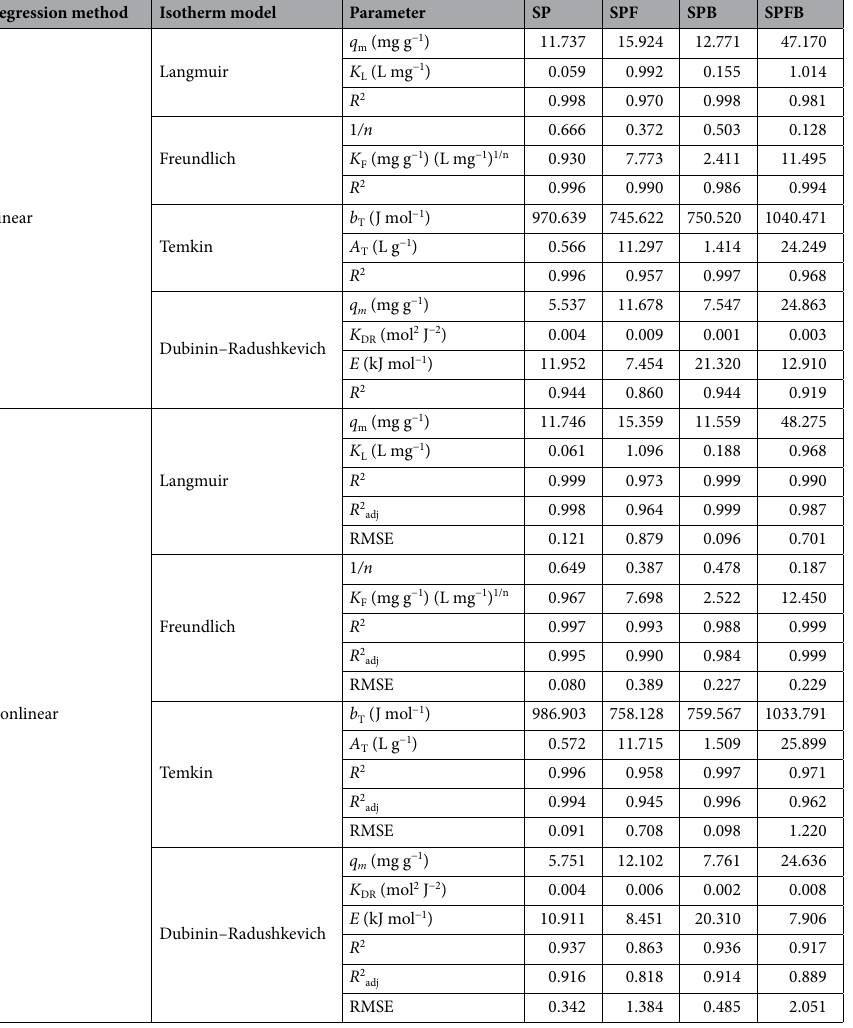
Table 4. The comparison of linear and nonlinear isotherm parameters for lead adsorptions on sawdust powder (SP), sawdust powder doped iron (III) oxide-hydroxide (SPF), sawdust beads (SPB), and sawdust powder doped iron (III) oxide-hydroxide beads